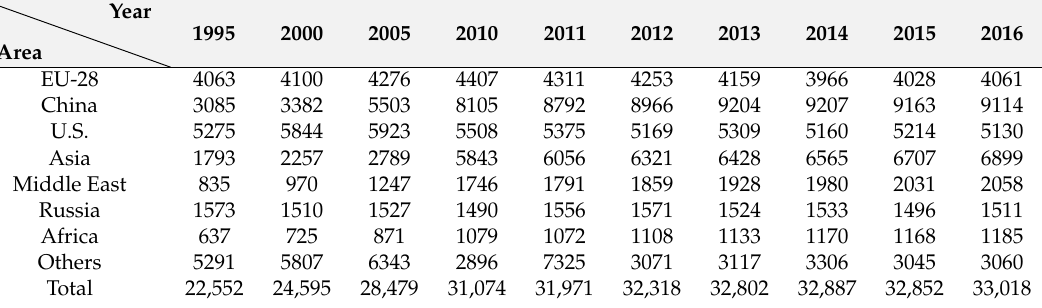
Table 1. Global carbon dioxide emissions. Unit: million